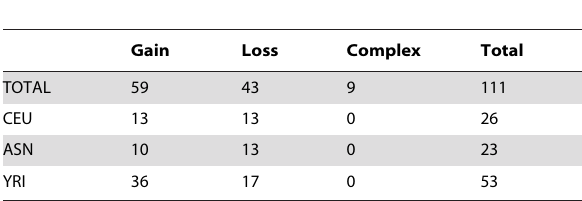
Table 1. Combined results of Copy Number Variant (CNV) changes in HapMap populations using genome-wide aCGH platforms.